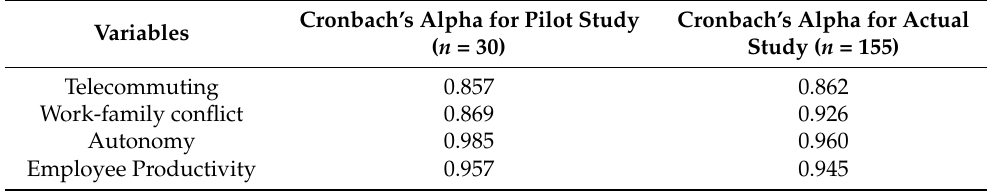
Table 3. Reliability of the